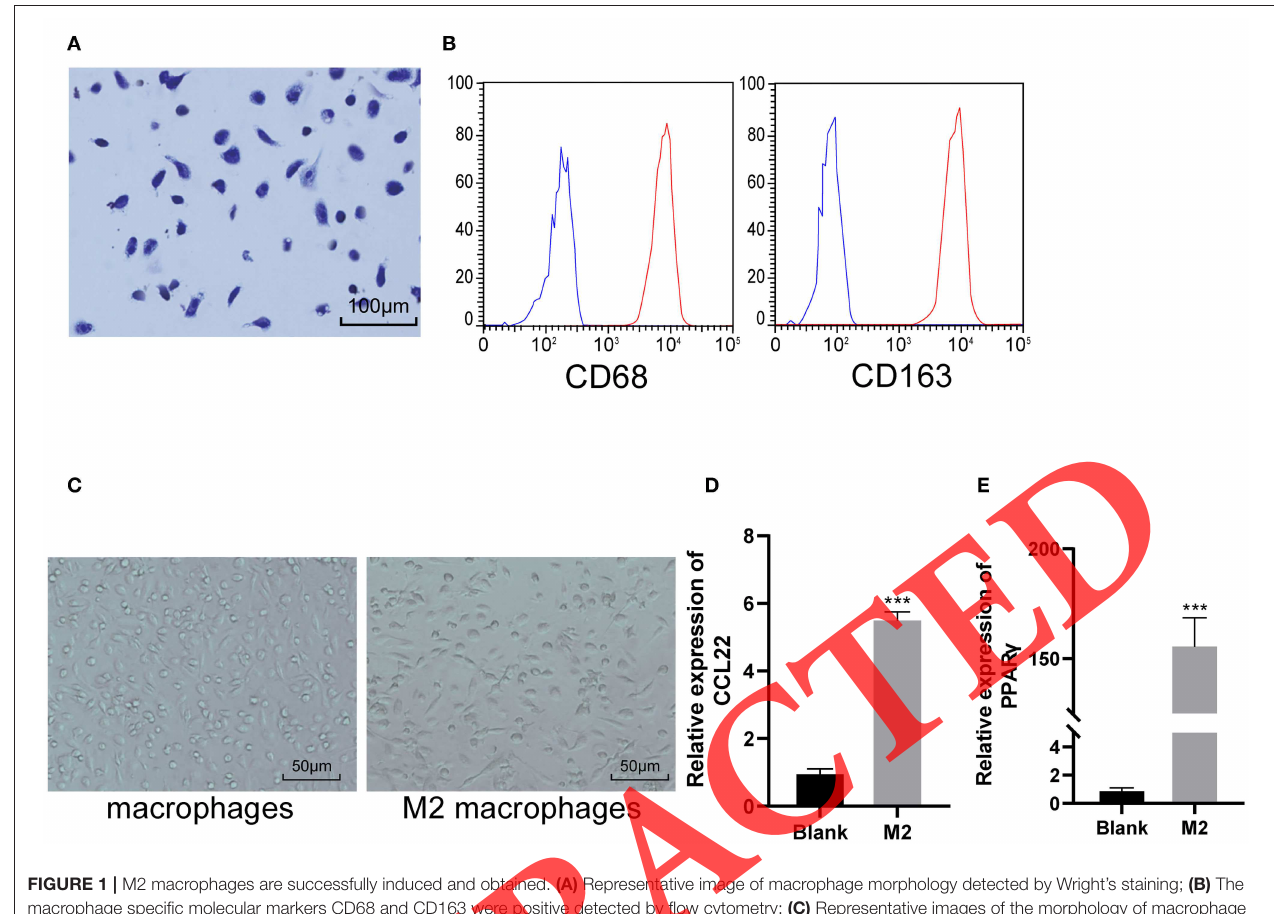
FIGURE 1 | M2 macrophages are successfully induced and obtained. (A) Representative image of macrophage morphology detected by Wright’s staining; (B) The macrophage specific molecular markers CD68 and CD163 were positive detected by flow cytometry; (C) Representative images of the morphology of macrophage and M2 macrophage under an optical microscope; (D,E) RT-qPCR was used to detect the typical polarization molecules CCL22 and PPAR γ . vs. the blank group, *** p < 0.001. Data were analyzed with the t -test. Repetitions =